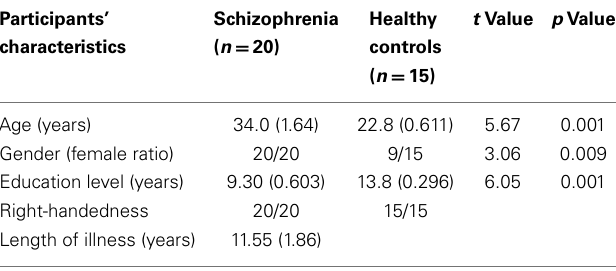
Table 1 | Characteristics of the groups studied in Experiment 1 (patients with schizophrenia and control participants).